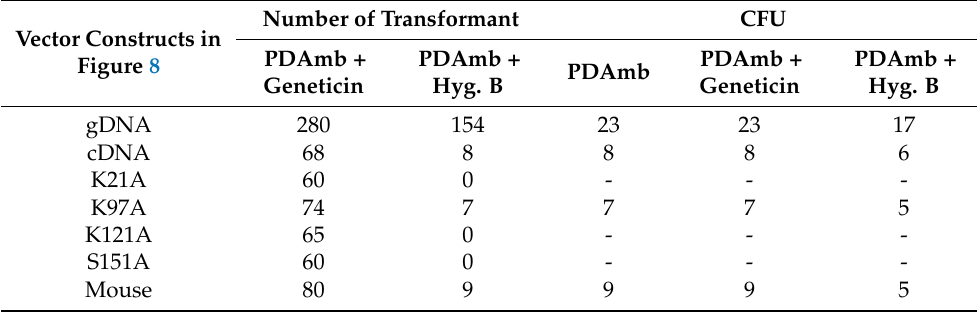
Table 1. Numbers of transformants using various complementing CpRan1 vectors on different selection media and numbers of resulting hygromycin B-resistant transformants used for spore harvesting and single-spore